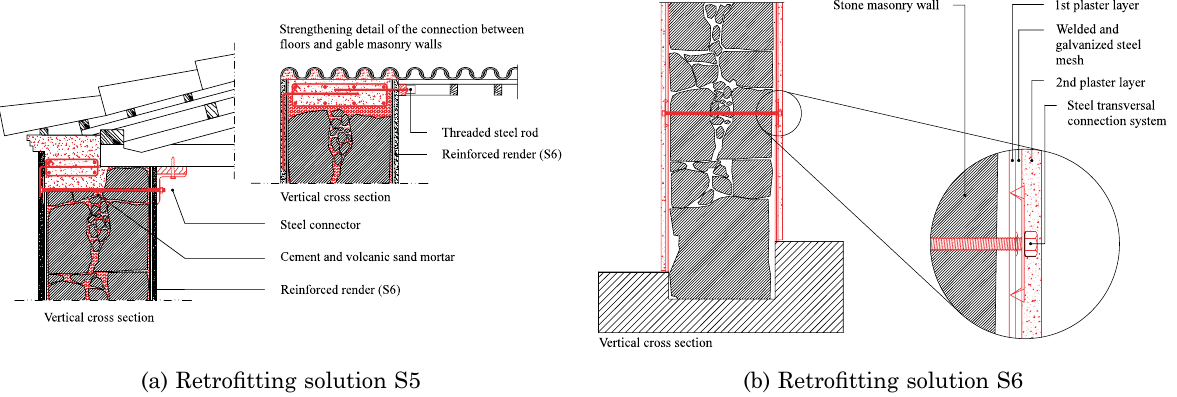
fig. 3. details of retrofitting solutions S5 of package rP2 (a) and S6 of rP3 (b), adapted from Costa